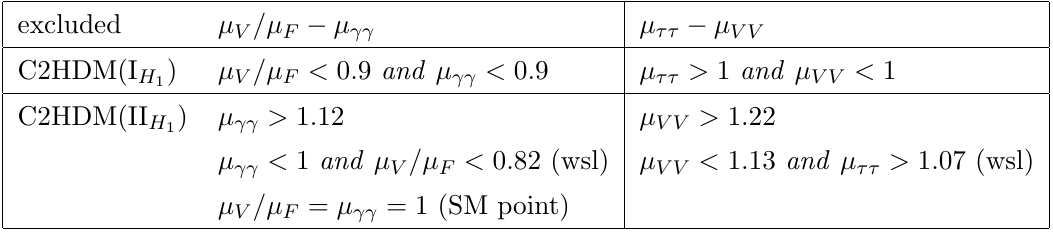
Table 13 . Distinguishing features between the C2HDM and 2HDM rates for scenarios with (cid:24) c > 1: the C2HDM excluded regions given here are still allowed by the 2HDM. Note that the wrong-sign limit (wsl) regions are excluded due to the applied constraints and not due to (cid:24) c > 1.